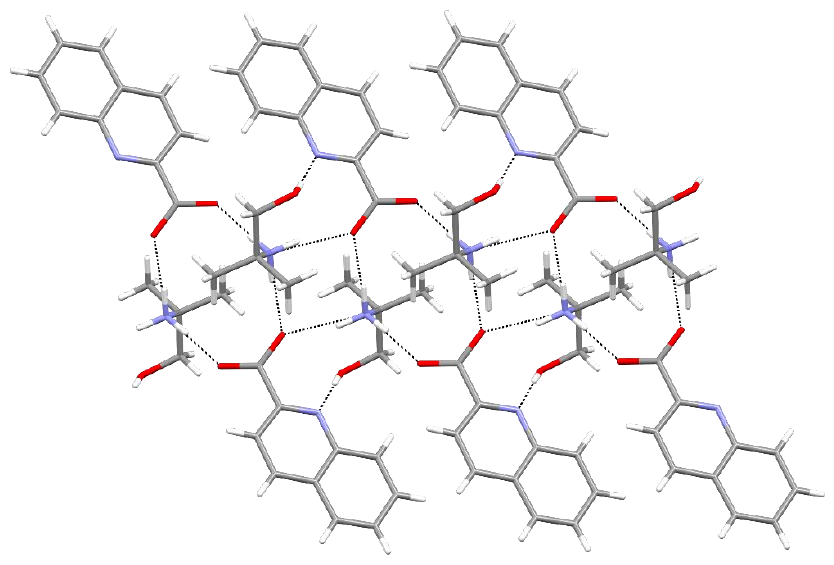
Figure 5. Section of a chain in 3a .